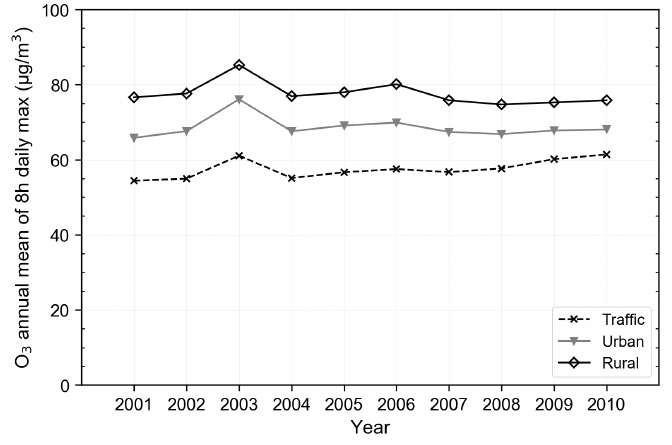
Figure 2. European historical trend. O 3 annual mean of daily 8-h max in traffic, urban and rural AQMS (excel data on supplementary info)